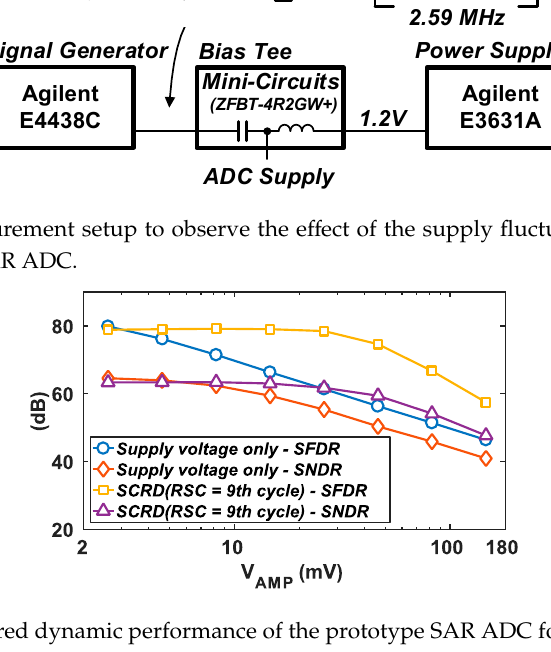
Figure 21. The measured dynamic performance of the prototype SAR ADC for the supply reference and the SCRD by varying V AMP .